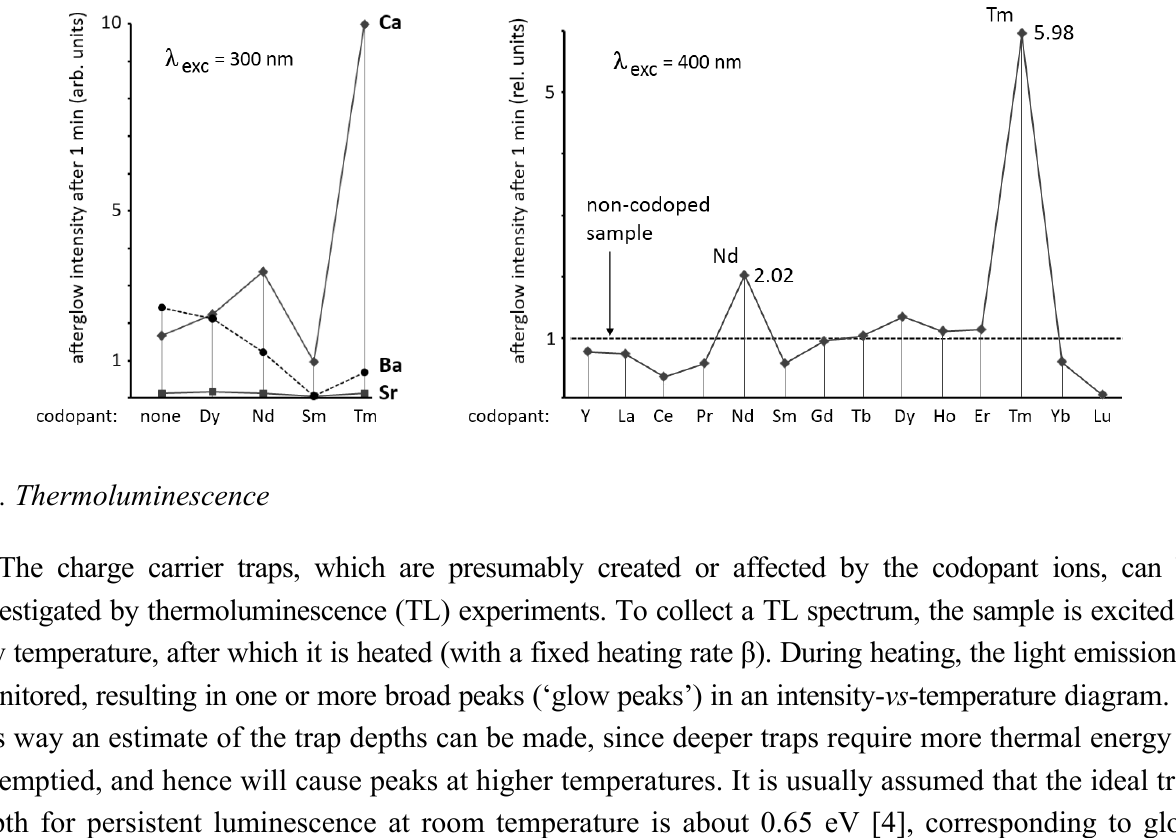
Si N :Eu,R 2 5 8